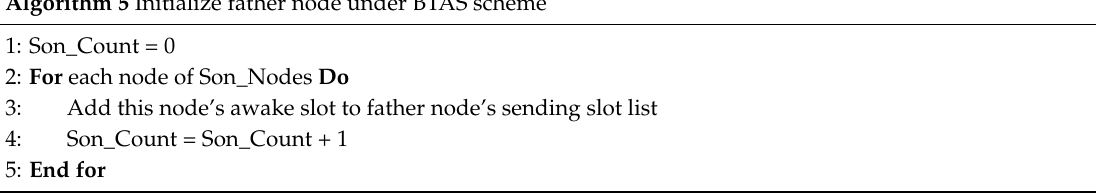
Algorithm 5 Initialize father node under BTAS